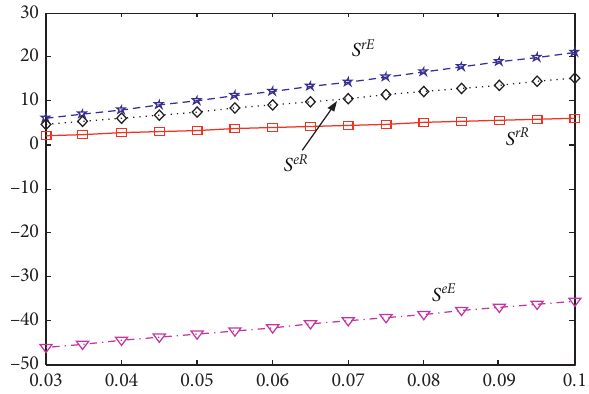
Figure 5: Optimal service level over ρ